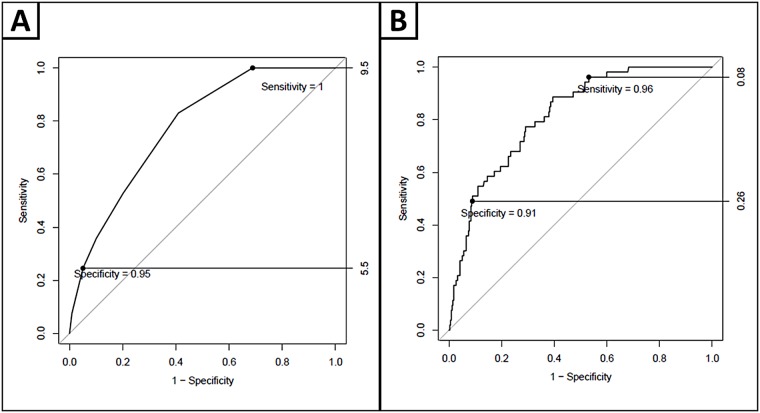
ROC curves displaying DOC cog diagnostic cut-points, for high sensitivity and specificity and with diagnostic cut-points with a logistic regression applied, controlling for age, sex and education.